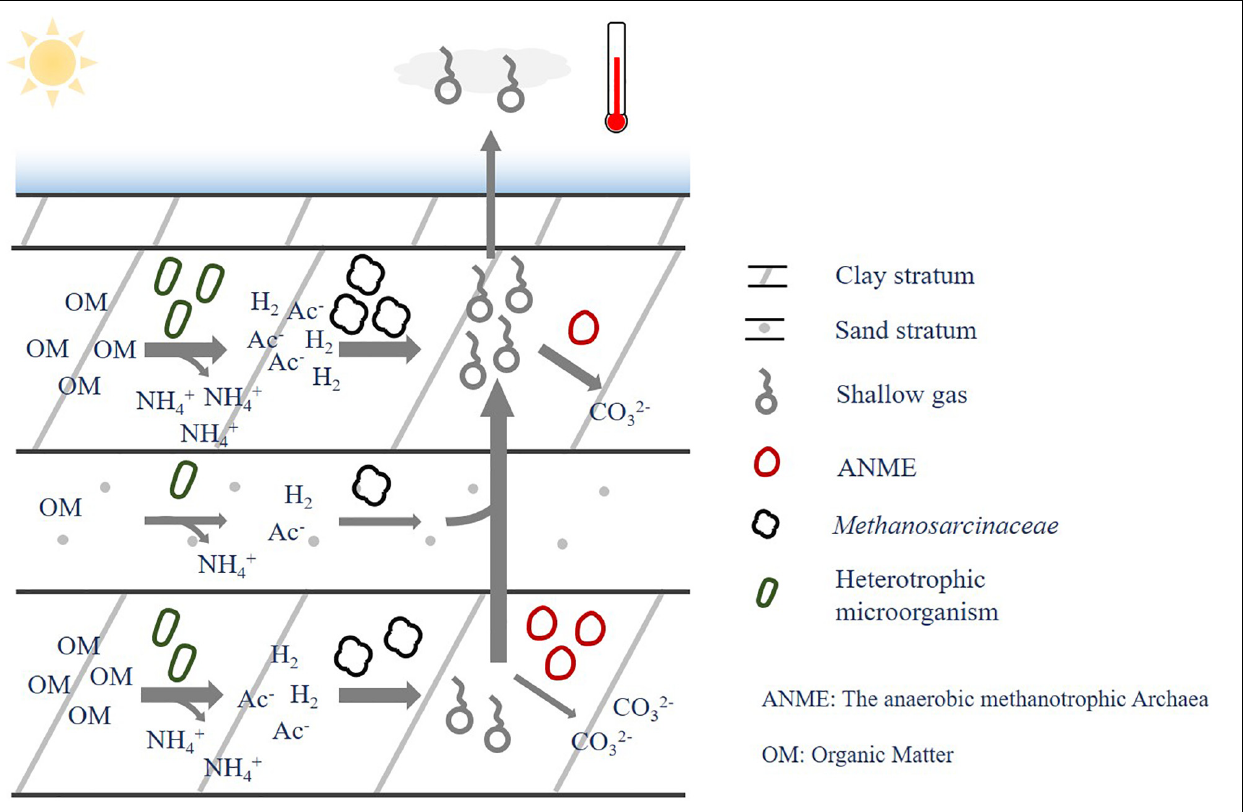
FIGURE 9 | Relationship between sediment type, environmental factors, microbial communities and